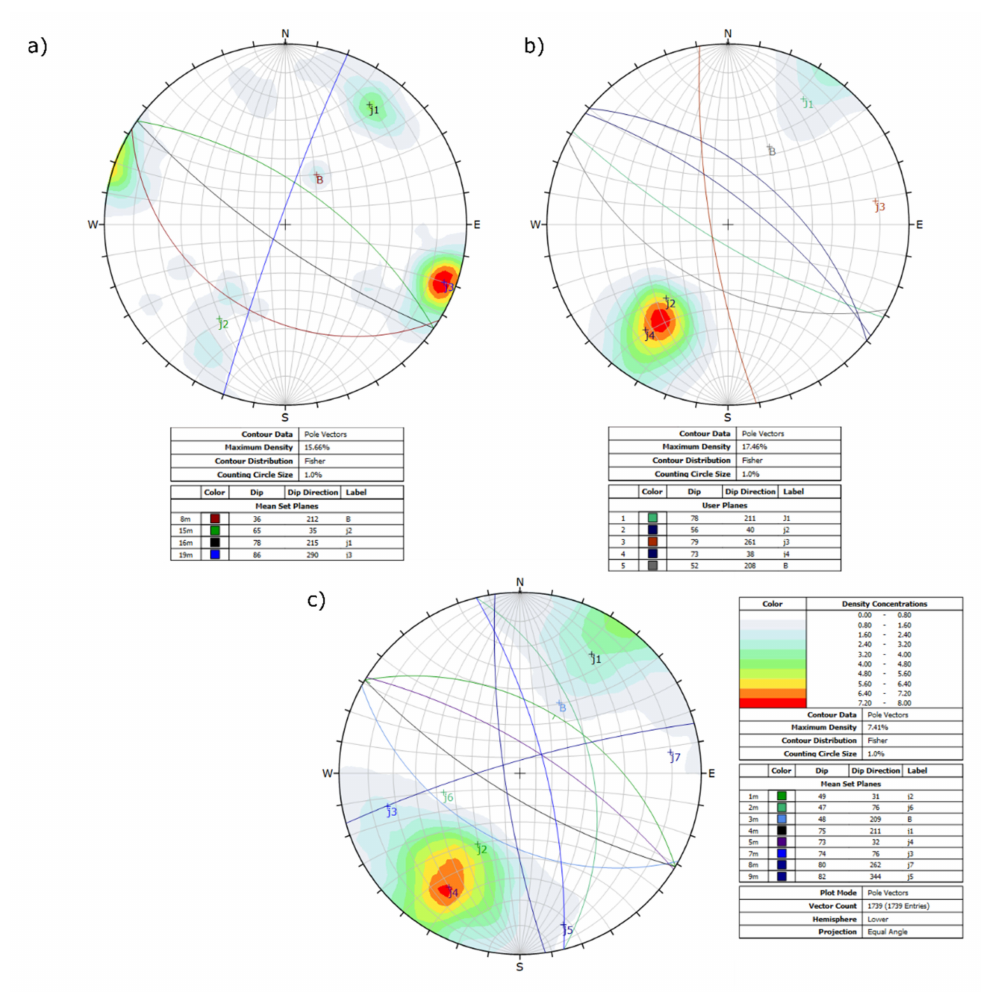
Figure 10. Stereographic projections (lower hemisphere, equal angle) of fieldwork data ( a ) field data; ( b ) DCS approach; ( c ) FACETS